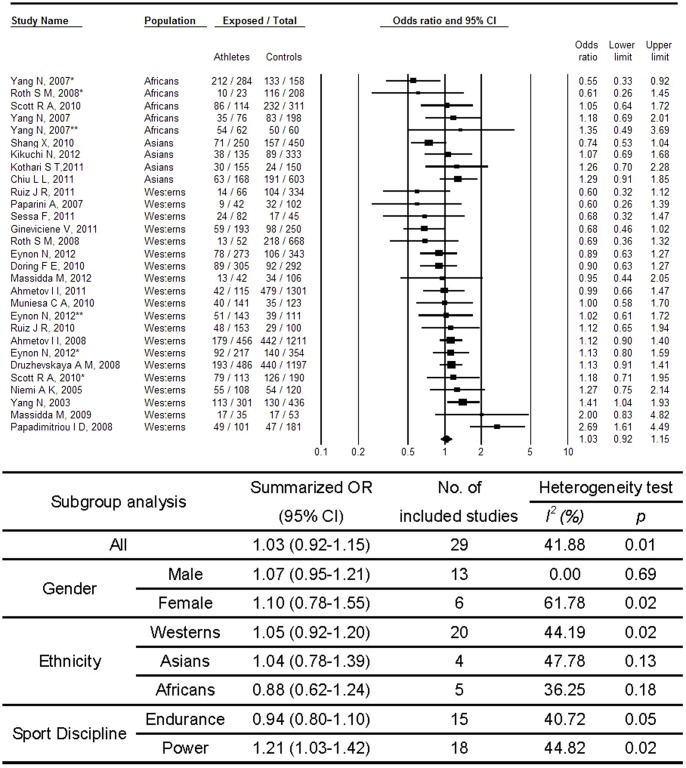
Meta-analysis of the association between sport performance and ACTN3 polymorphism (RR vs. RX+XX).Abbreviation: CI, confidence interval; OR, odds ratio. *, **Different study population from the same article.